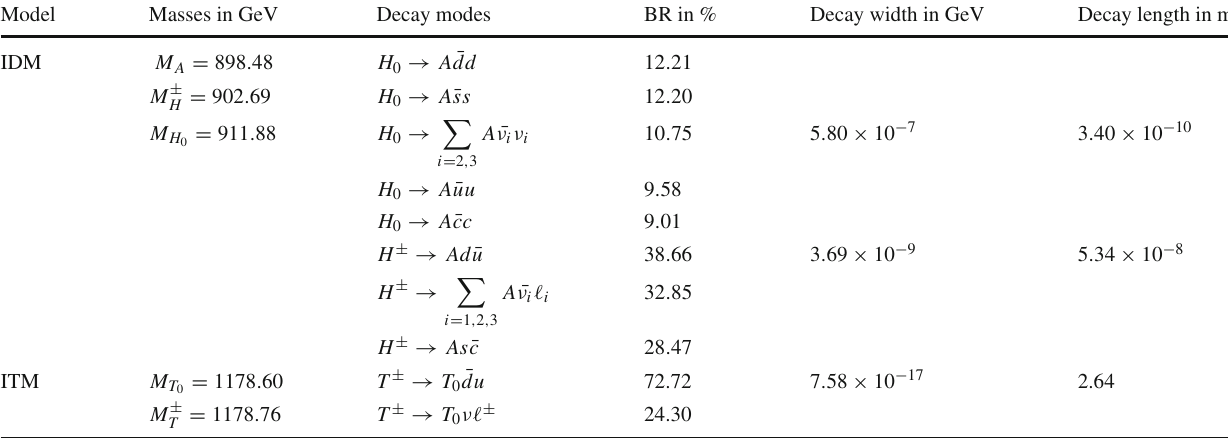
Table 2 Dominant 3-body decay modes and corresponding branching ratios, decay width and decay length for the Z 2 -odd Higgs bosons for the benchmark points of IDM and ITM Model